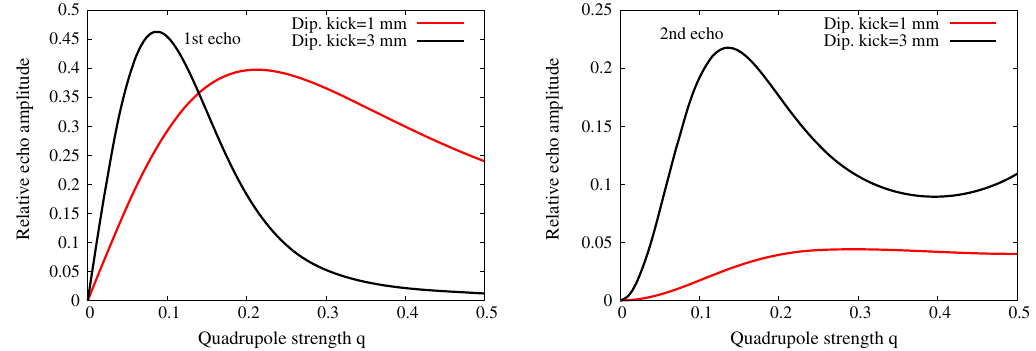
FIG. 2. Left: relative amplitude of the first echo vs quadrupole strength for two dipole kicks. Right: relative amplitude of the second echo for the same two dipole kicks. The initial emittance is the same in both